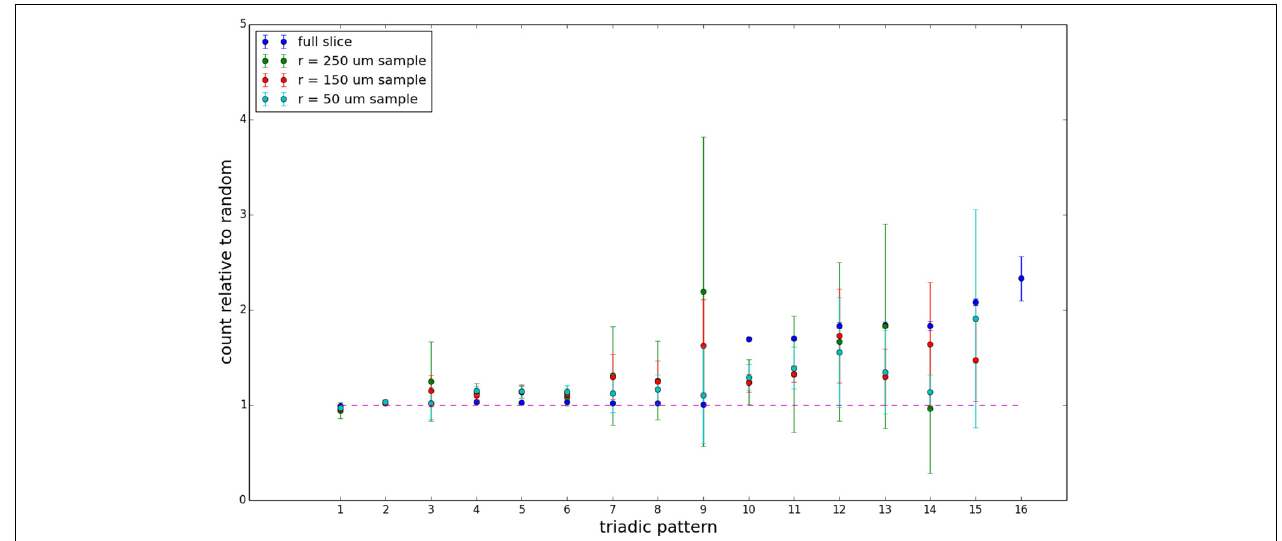
FIGURE 11 | Bidirectionally corrected triadic motif counts for 300 µ m slice. Error bars indicate standard error of the mean. Average over five